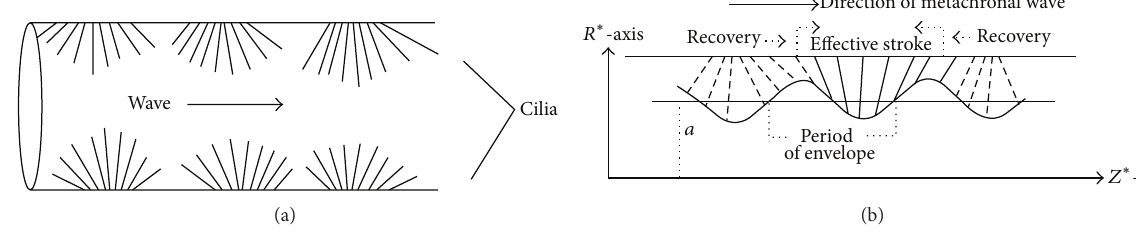
Figure 1: Wave motion due to cilia: (a) ciliated tube and (b) metachronal wave